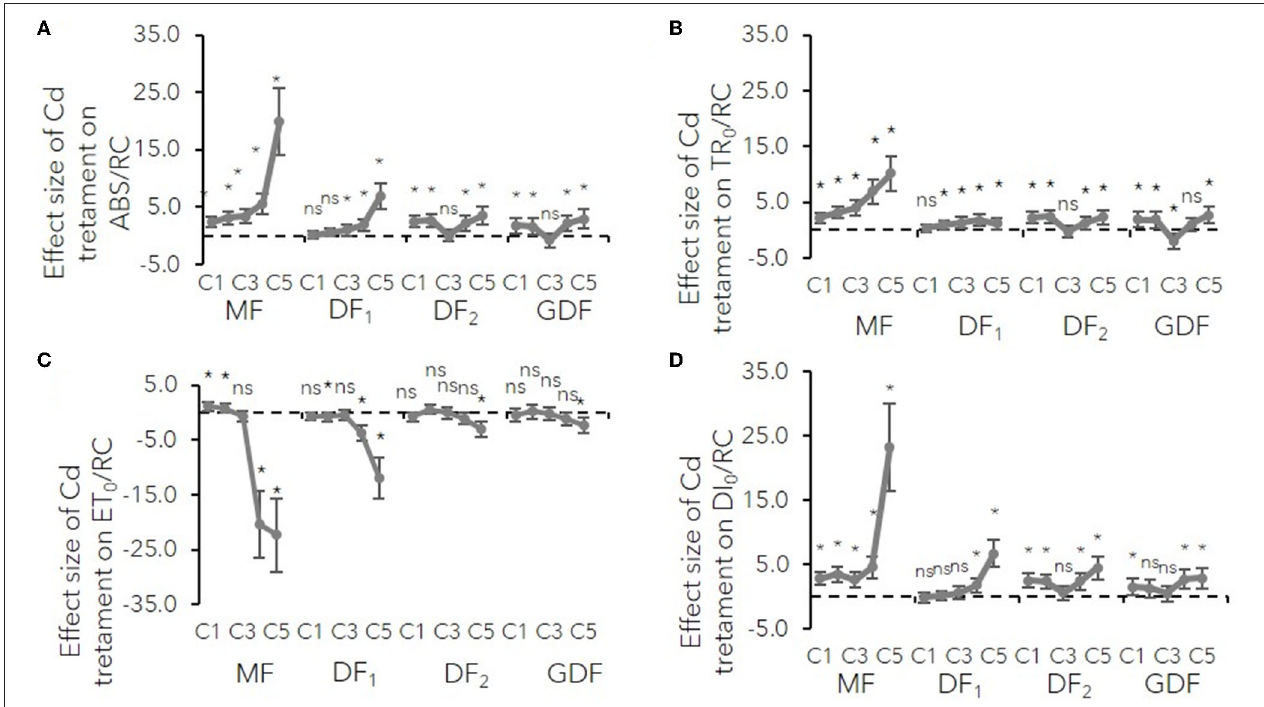
FIGURE 2 | Mean effect sizes (Hedges d) and bias-corrected bootstrap 95% confidence interval for the overall effect of Cd treatment on specific energy fluxes (per reaction center, RC) for (A) absorption (ABS/RC), (B) trapping (TR 0 /RC), (C) electron transport (ET 0 /RC) and (D) dissipation (DI 0 /RC). Effect sizes are based on mean differences between treatment and the control (C0) after 72 h of exposure to Cd concentration from 7 µ M–C1 to 111 µ M–C5. The dashed line shows Hedges d = 0. When confidence intervals overlap zero, the effect sizes are not significantly different from zero ( p -values for mean differences are obtained by 2-tailed t -test, ns for p > 0.05; * p <